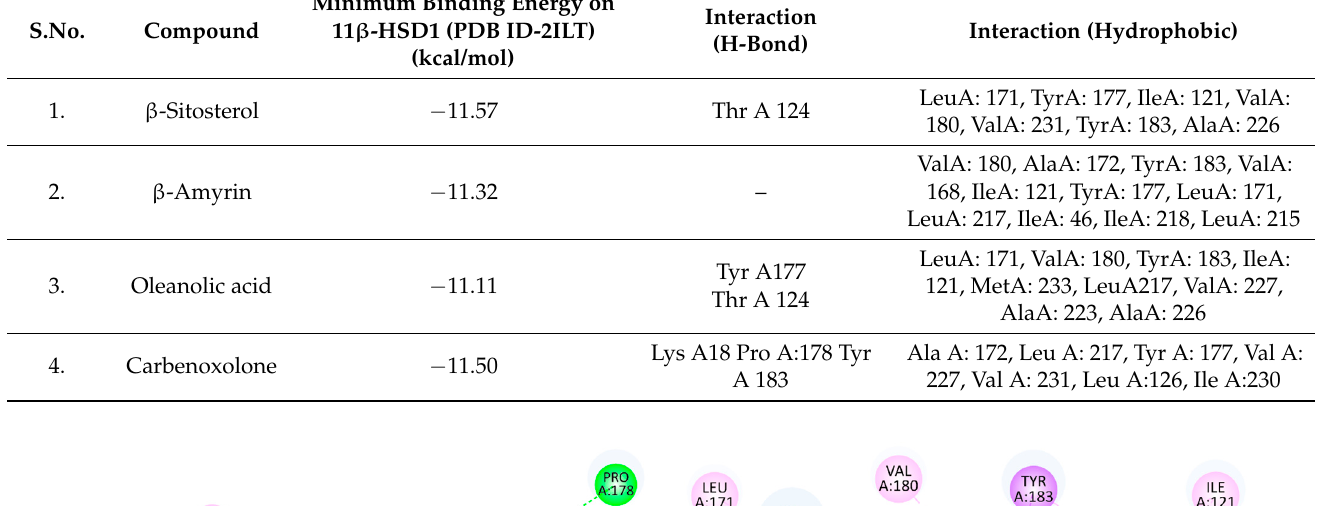
Table 1. Summary of selected constituents and reference compounds (carbenoxolone). Chemical struc- tures Autodock docking scores, hydrogen bond interactions, and hydrophobic interaction residues.